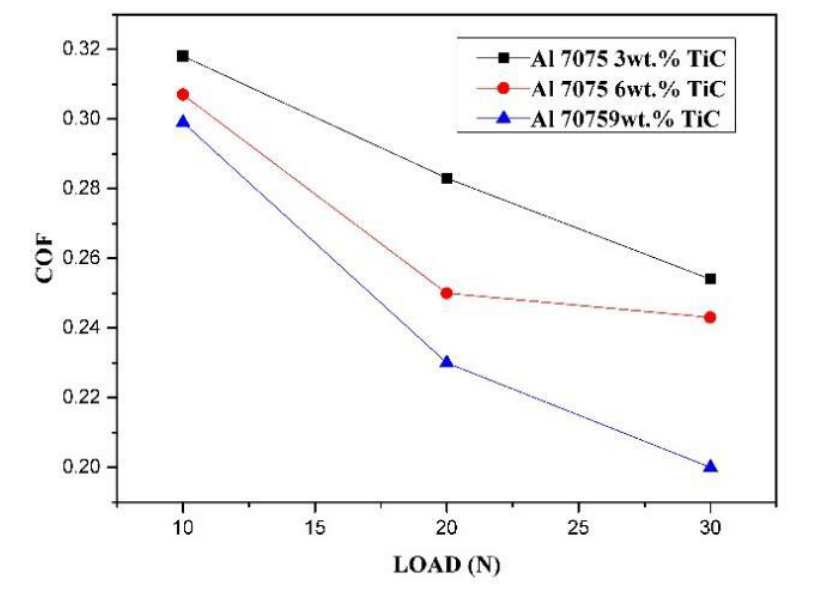
Fig. 10. Variation of coefficient of friction of Al 7075/ TiC composites with load at a constant sliding velocity of